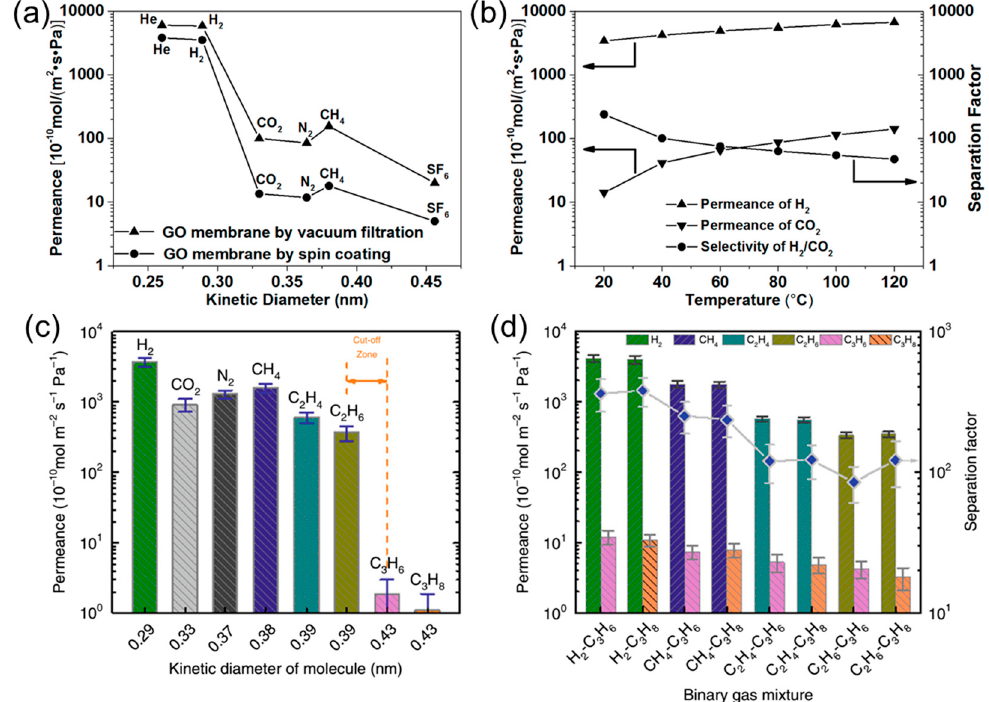
Figure 6. ( a ) Comparison of gas permeances of GO membranes fabricated by spin coating and vacuum filtration. ( b ) Effect of temperature on H 2 /CO 2 separation performance of the spin-coated GO membranes. Adapted with permission from [25]. Copyright (2016) American Chemical Society. ( c ) Pure-gas and ( d ) mixed-gas permeances through the ED-GO membranes at room temperature. Adapted with permission from [26].